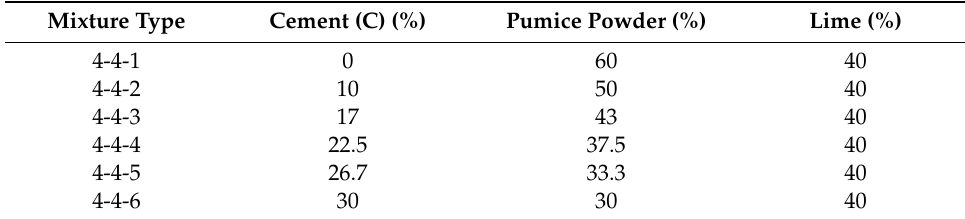
Table 10. Type 4-4 mixing ratios.